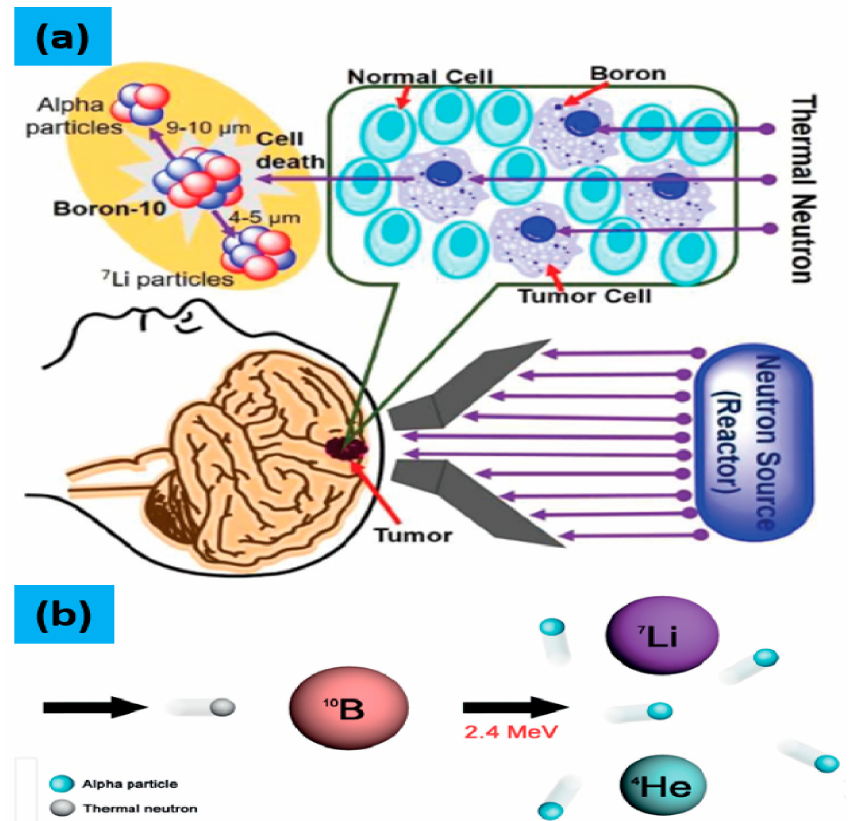
Figure 2. ( a ) Graphical depiction of the principle of BNCT, that show how localized boron particles within the tumor can be bombarded with low energy thermal neutrons to produce alpha particles (Reprint from Ref. [61]). ( b ) BNCT reaction scheme, where the thermal neutrons were bombarded on 10 B resulting in a nuclear reaction releasing α particles and 7 Li nuclei within a tumor cell, o ff ering a localized lethal e ff